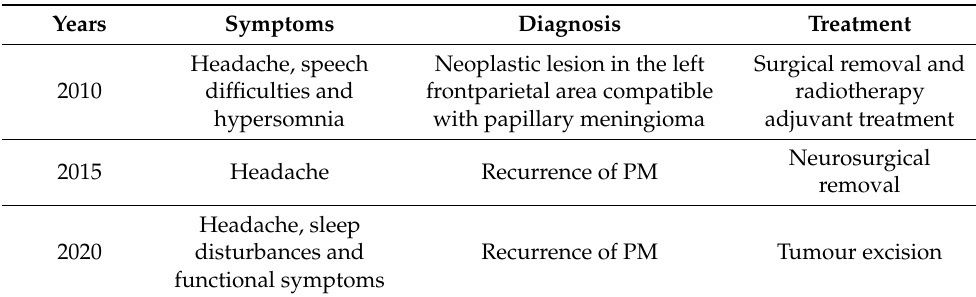
Table 1. Summary of the patient’s medical history mentioning symptoms, diagnosis, and therapeutic treatment.